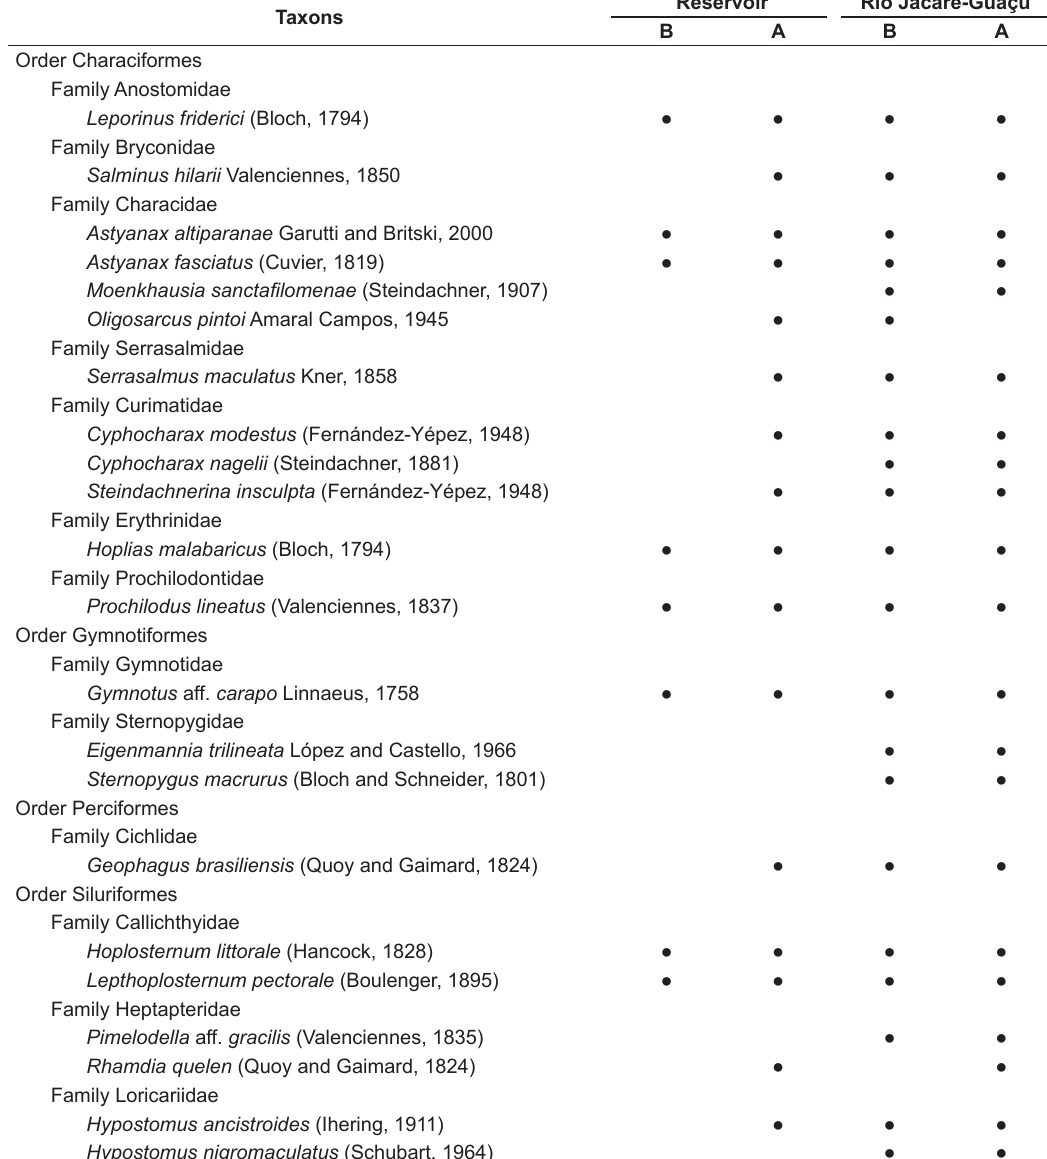
Table 2. Taxonomic list of the fish fauna and the occurrence of species before (B) and after (A) the dredging and macrophyte